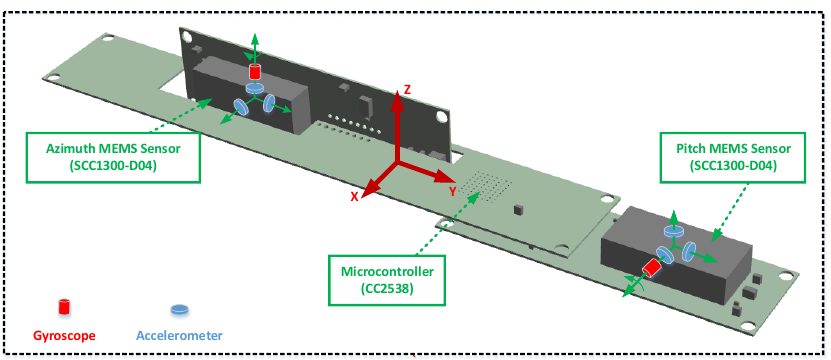
Figure 3. Configuration of the MGWD device. Each MEMS sensor is composed of a single-axis gyroscope and three-axis accelerometers. The body frame is the right (X-axis), forward (Y-axis) and up (Z-axis) direction.